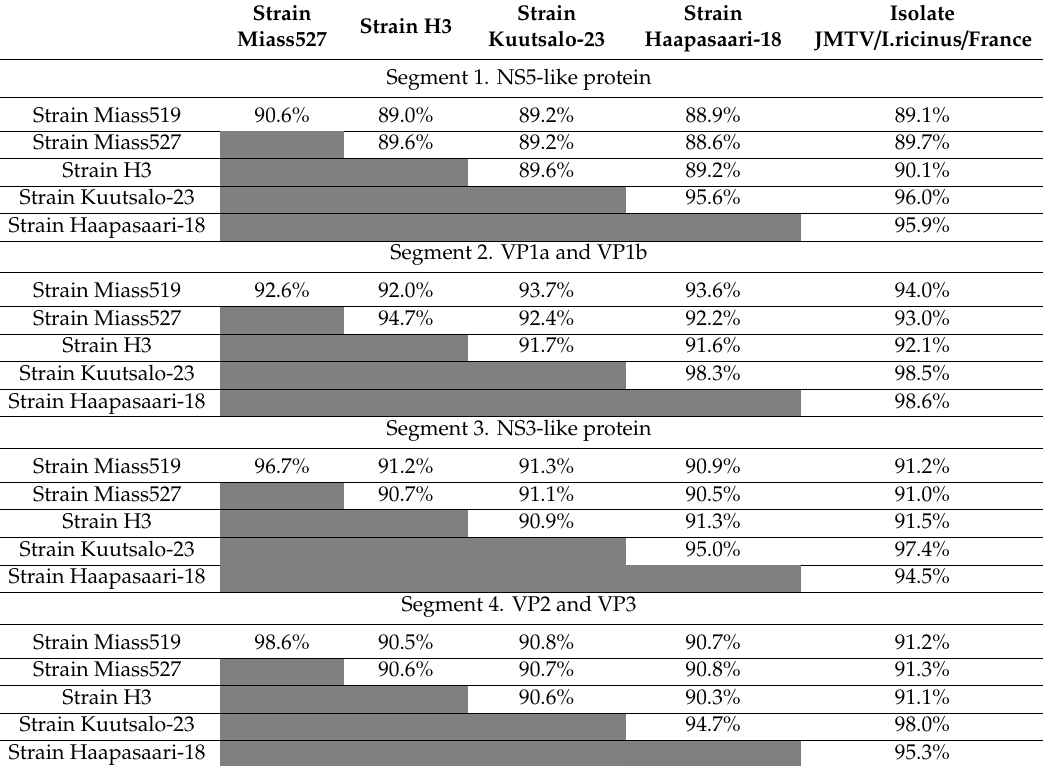
Table 2. Percentage nucleotide identity of the four genome segments of di ff erent strains of Alongshan virus for which full genomes were available at the time of writing.